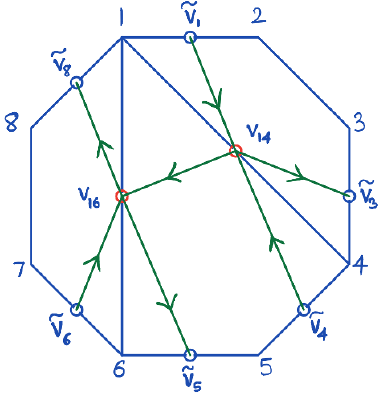
Figure 3 . Paths within the three cells are marked in